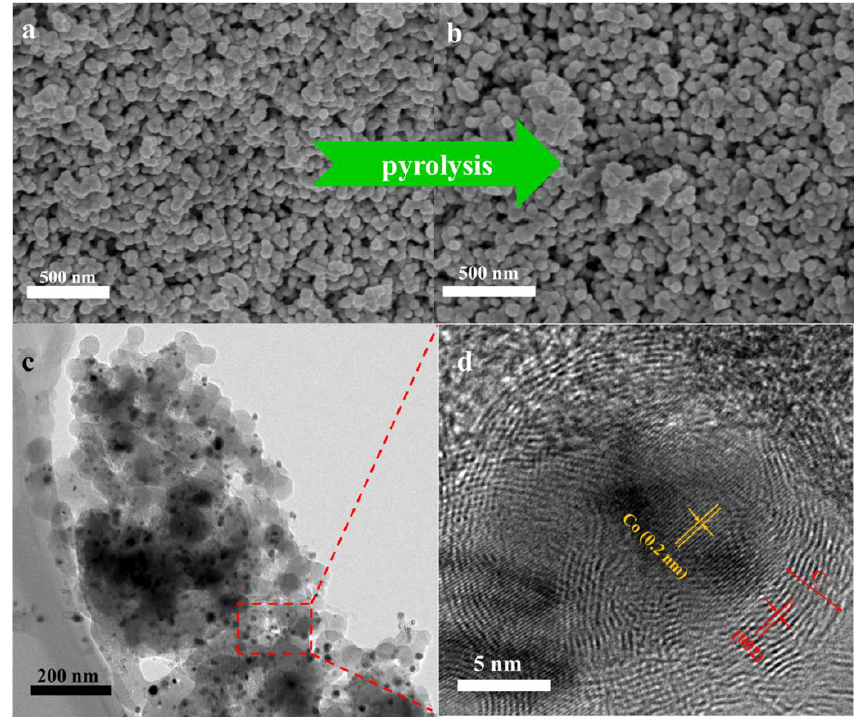
Figure 5. SEM images of ( a ) Bimetallic metal-organic frameworks (MOFs) precursor; and ( b ) the MNPC; ( c ) TEM and ( d ) HRTEM images of the MNPC.